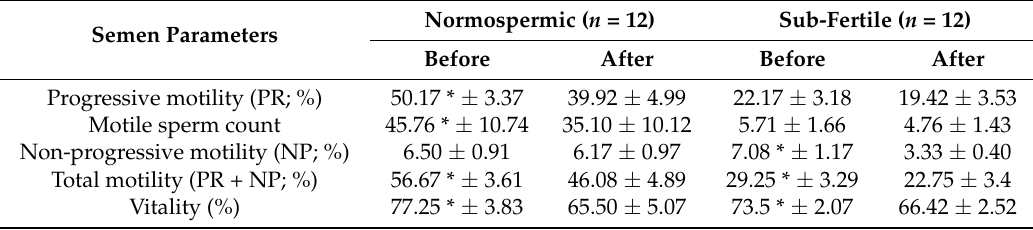
Table 2. Effect of hydrogen peroxide on semen parameters of normorspermic and sub-fertile subjects. Normospermic ( n = 12) Sub-Fertile ( n = 12) Semen Parameters Before After Before After Progressive motility (PR; %) 50.17 * ± 3.37 39.92 ± 4.99 22.17 ± 3.18 19.42 ± 3.53 Motile sperm count 45.76 * ± 10.74 35.10 ± 10.12 5.71 ± 1.66 4.76 ± 1.43 Non-progressive motility (NP; %) 6.50 ± 0.91 6.17 ± 0.97 7.08 * ± 1.17 3.33 ± 0.40 Total motility (PR + NP; %) 56.67 * ± 3.61 46.08 ± 4.89 29.25 * ± 3.29 22.75 ± 3.4 Vitality (%) 77.25 * ± 3.83 65.50 ± 5.07 73.5 * ± 2.07 66.42 ± 2.52 Values are mean ± SEM; * indicates p < 0.05 compared to parameters after H 2 O 2 treatment (Student’s t test for pair